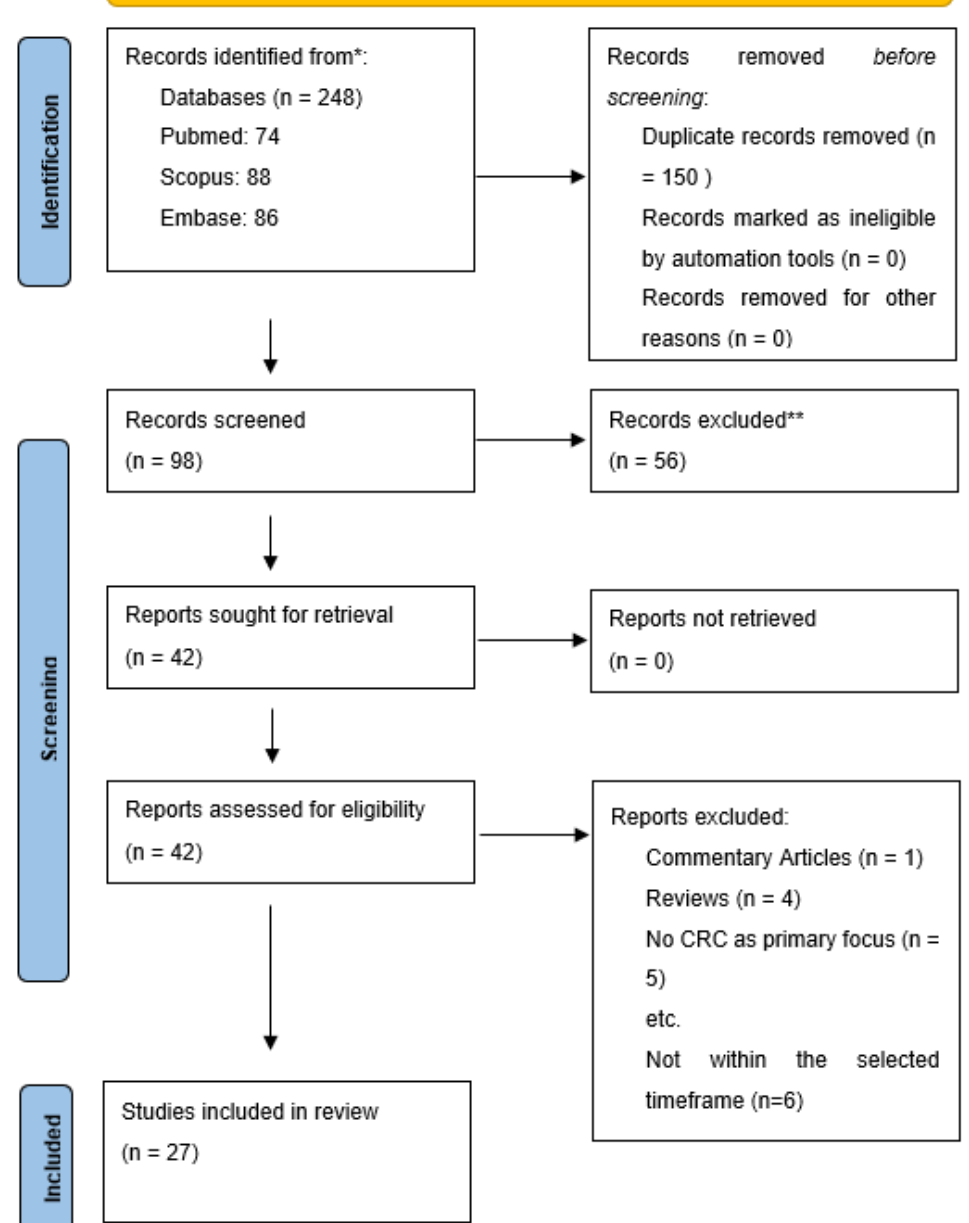
Figure 1. PRISMA Diagram. * Consider, if feasible to do so, reporting the number of “records identified from” each database or register searched (rather than the total number across all databases/registers). ** If automation tools were used, indicate how many records were excluded by a human and how many were excluded by automation tools.